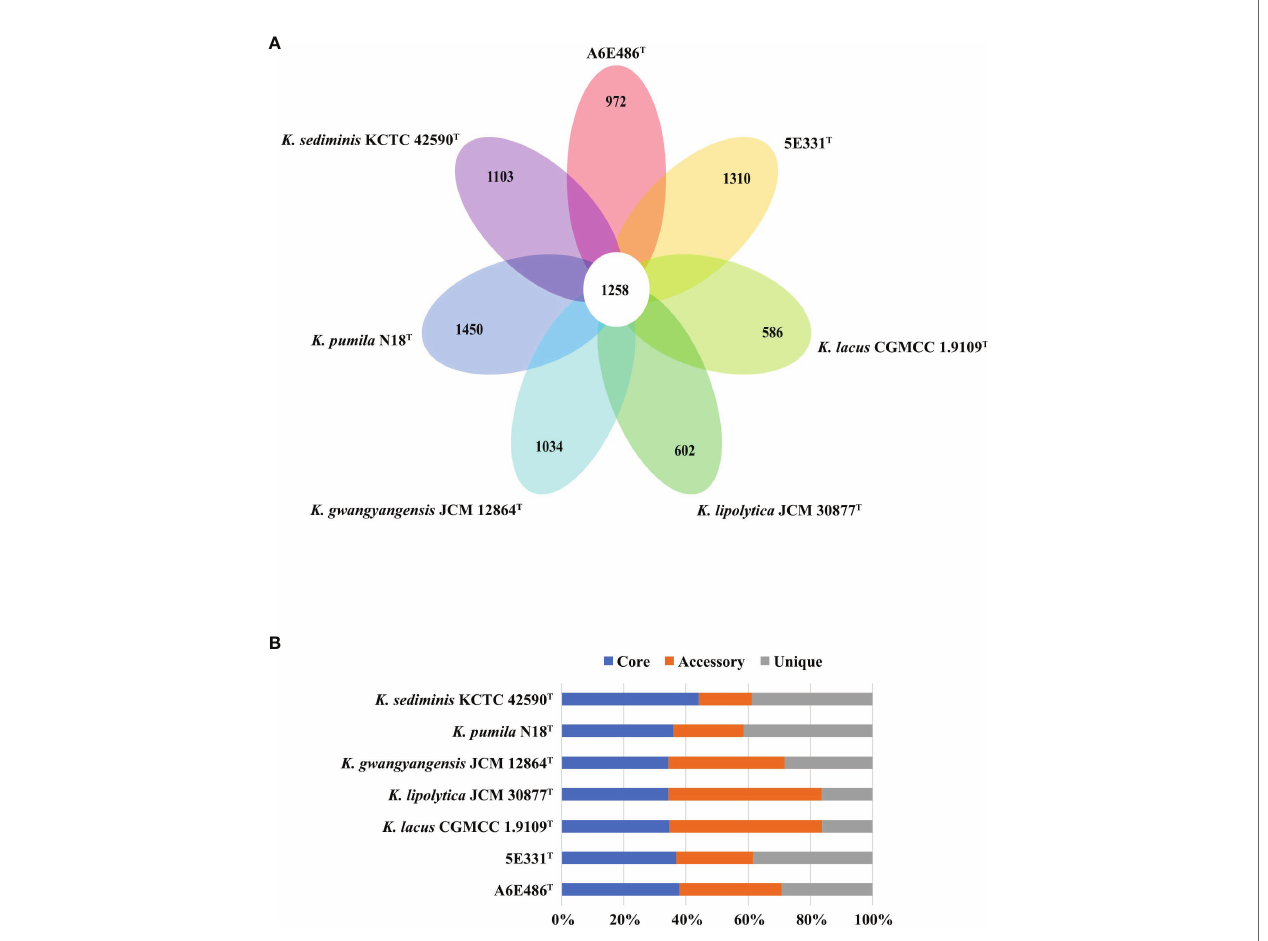
FIGURE 3 | Comparisons of Kordiimonas orthologous protein groups in the seven Kordiimonas genomes. (A) Venn diagram displaying the numbers of core gene families and unique genes for each of the seven Kordiimonas strains. (B) Percentage of core, accessory, and unique genes in each of the seven